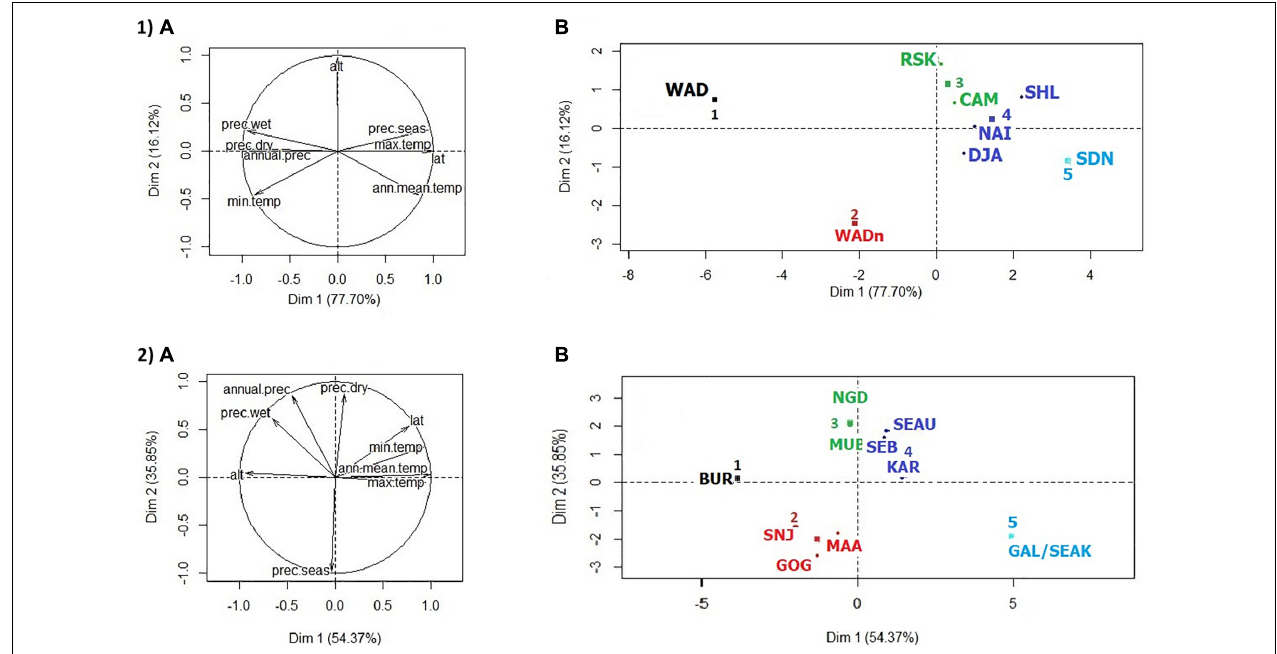
FIGURE 2 | Goat distribution areas analyses as a function of environmental variables. (1) HCPC analysis for the West-Central African dataset. (A) PCA correlation circle. (B) PCA score plot by breed. (2) HCPC analysis for the East African dataset. (A) PCA correlation circle. (B) PCA score plot by breed. Colors represent the main clusters obtained by HCPC ( K = 5). PC 1 and PC 2 represent respectively principal components 1 and 2. alt., altitude in meters; temp., temperature in ◦ C × 10; prec., precipitation in millimeters; min., minimal; max., maximal; seas., seasonality; lat., latitude; ann. mean, annual